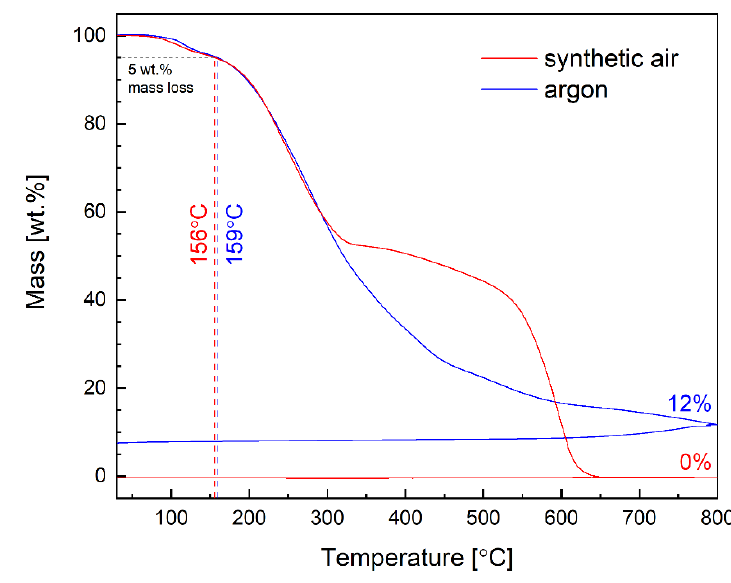
Figure 2. TGA curves of bTAThDaz recorded in air and argon atmospheres.